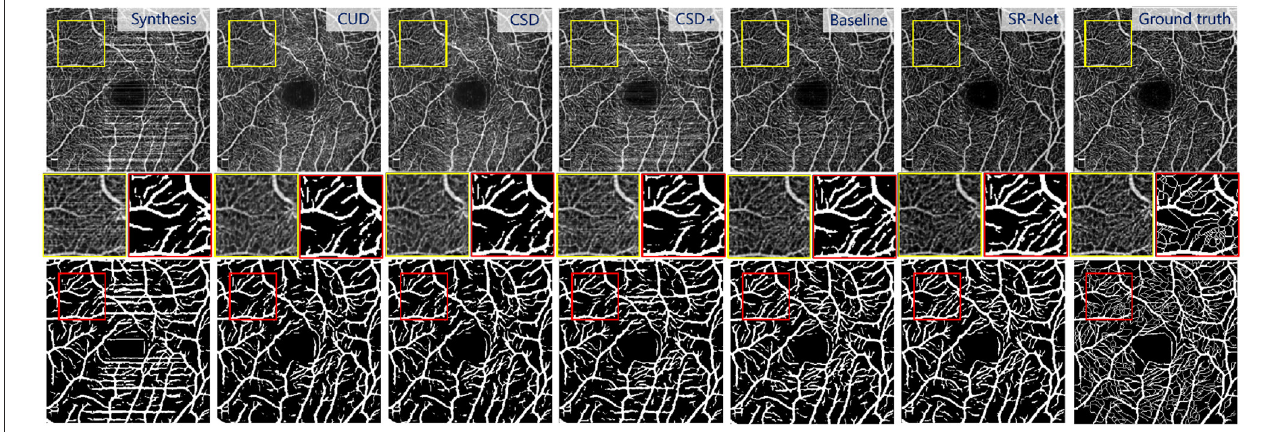
FIGURE8 Illustrative results using different stripe removal methods on a synthetic OCTA image ( i = 2) in ROSE dataset, and their vessel segmentation performances by OCTA-Net (4). Top : De-striped OCTA images by different methods. Bottom : vessel segmentation results. Middle : representative patches of de-striped and vessel segmentation